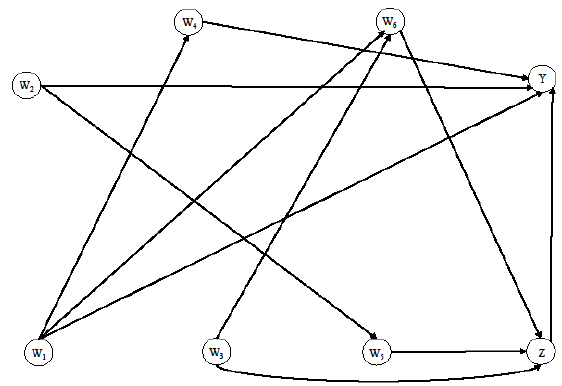
Figure 1. DAG of the simulated data.